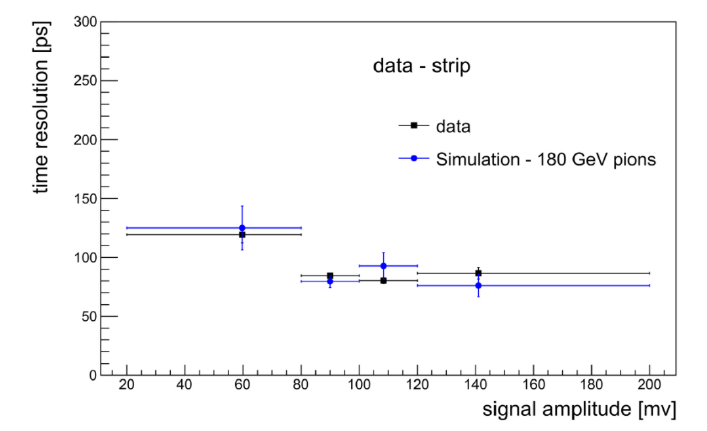
Figure 13. Time resolution as a function of signal amplitude for data (black squares) and simulated (blue circles) 180 GeV pion